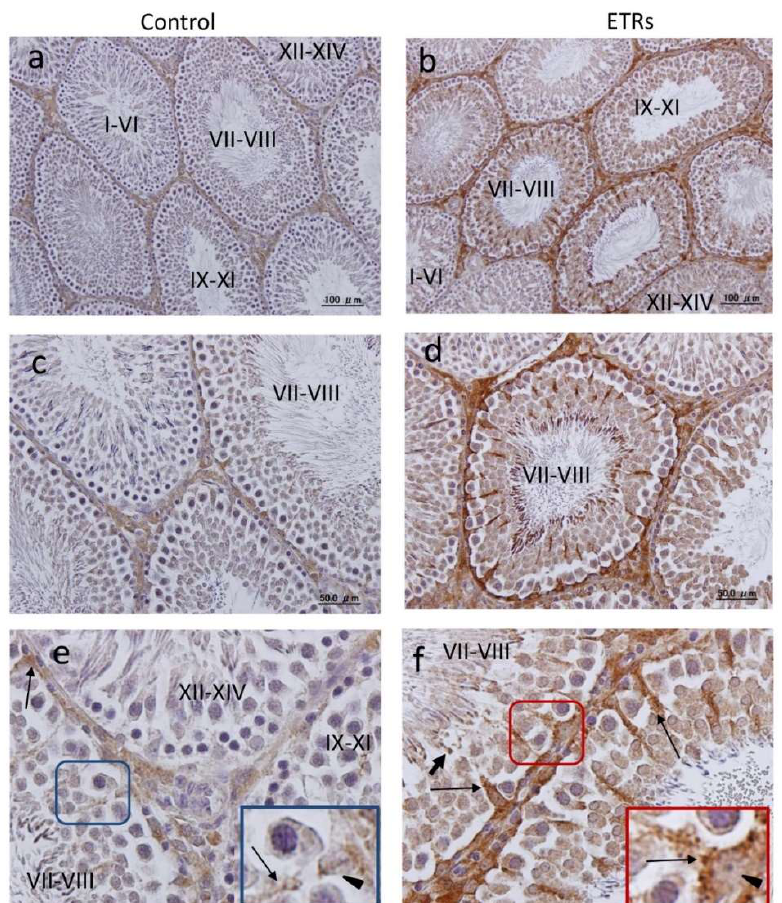
Figure 2. Immunolabeling for LC3 with highest expression in SCs of ETRs at stages VII–VIII of spermatogenic cycle. (( a , c , e ) control group; ( b , d , f ) ETRs). Higher magnifications of framed areas in ( e , f ) showing LC3 puncta (long arrows) in SCs are shown in the insets. The short arrows indicate LC3 dots in RBs. Black arrow heads mark SC nuclei.